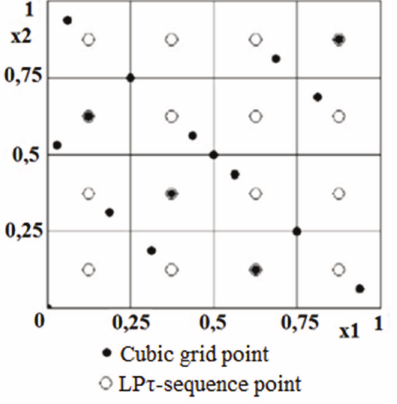
Fig. 1. Regular and improved grid at n = 2 (N = 16)